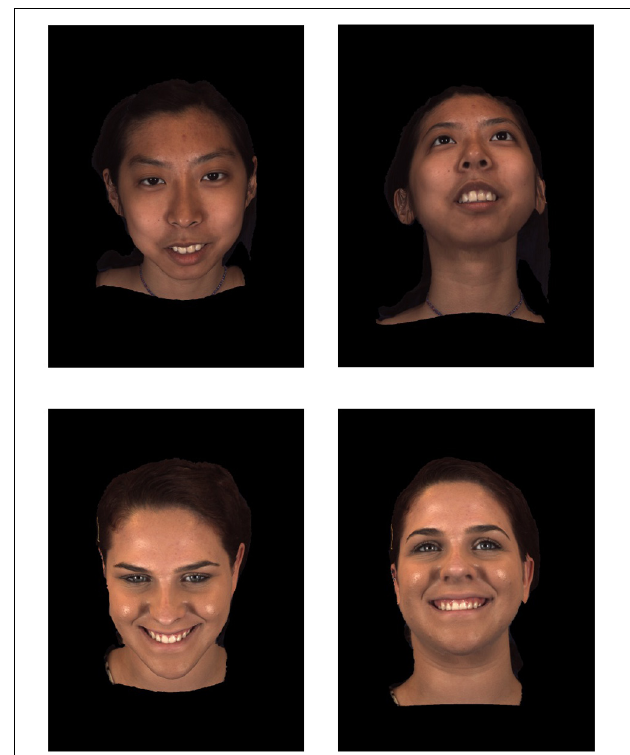
FIGURE 6 | Changing facial viewpoint along a 3D axis with upper and lower head tilts (The images pictured above were reproduced, modified and adapted from the facial database originally developed by Zhang et al. (2013, 2014). Copyright 2013–2017, The Research Foundation for the State University of New York and University of Pittsburgh of the Commonwealth System of Higher Education. All Right Reserved. BP4D-Spontaneous Database, as of: